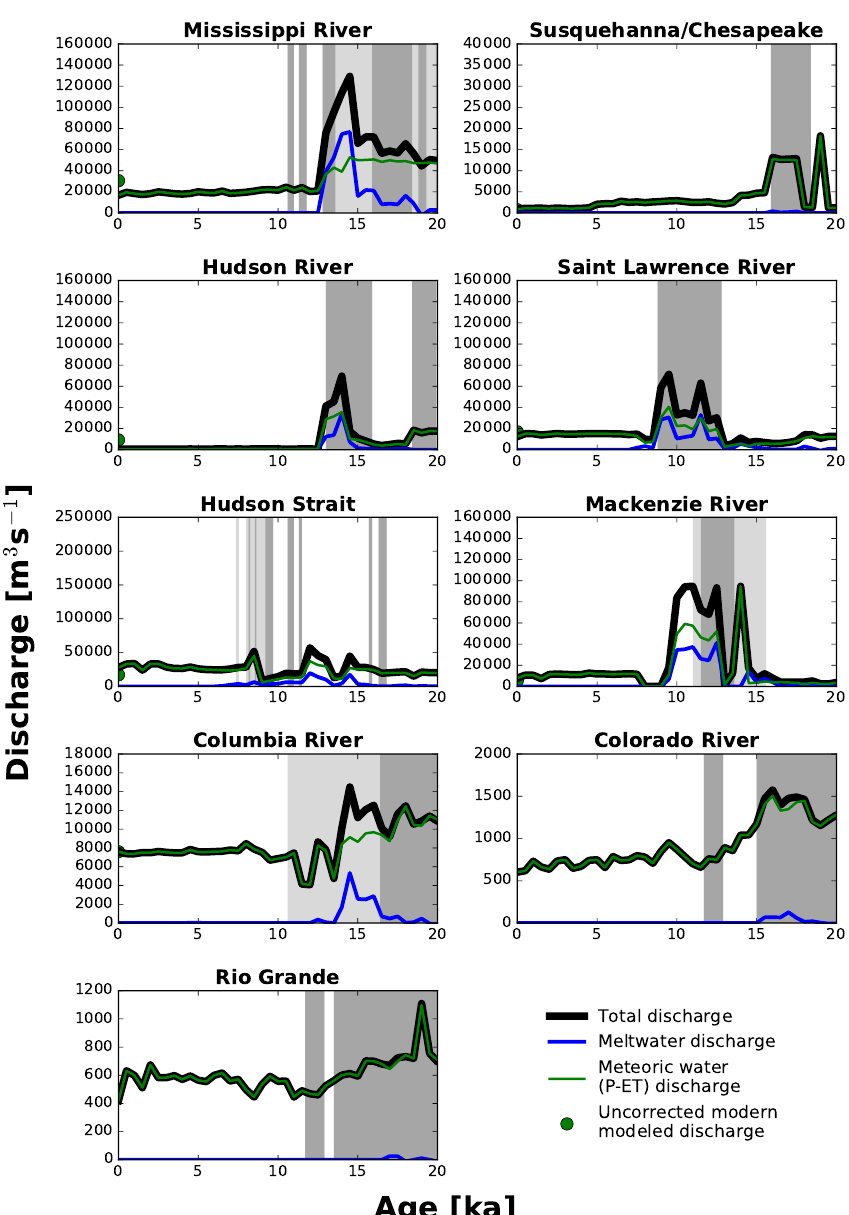
Figure 15. Computed discharge based on the ICE-6G/VM5a coupled ice-sheet–solid-Earth model (Argus et al., 2014; Peltier et al., 2015), compared to the geologic record of enhanced past discharge (gray shading: dark, direct record; light, inferred and/or less-enhanced discharge). Notes on the geologic record can be found in Fig.